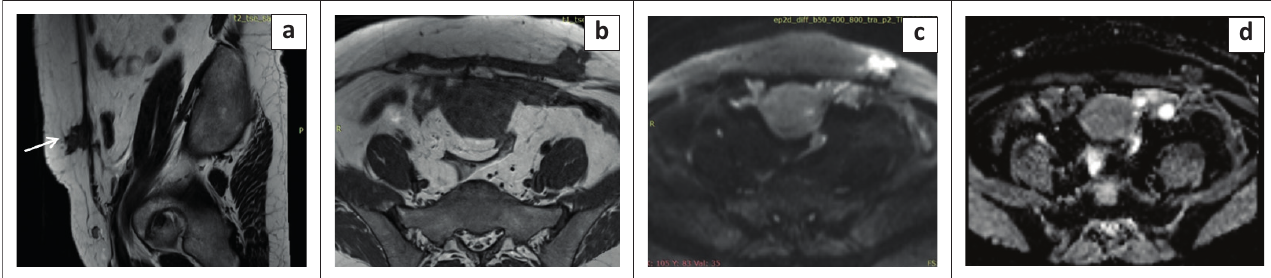
FIGURE 2: Sagittal T2W (a) and axial T1 W (b) MR images show a spiculated hypointense mass (arrow) in the subcutaneous plane in left lower anterior abdominal wall with loss of fat planes with the underlying rectus muscle, which shows normal signal. Diffusion weighted image (c) with corresponding ADC map (d) shows diffusion restriction within the lesion.